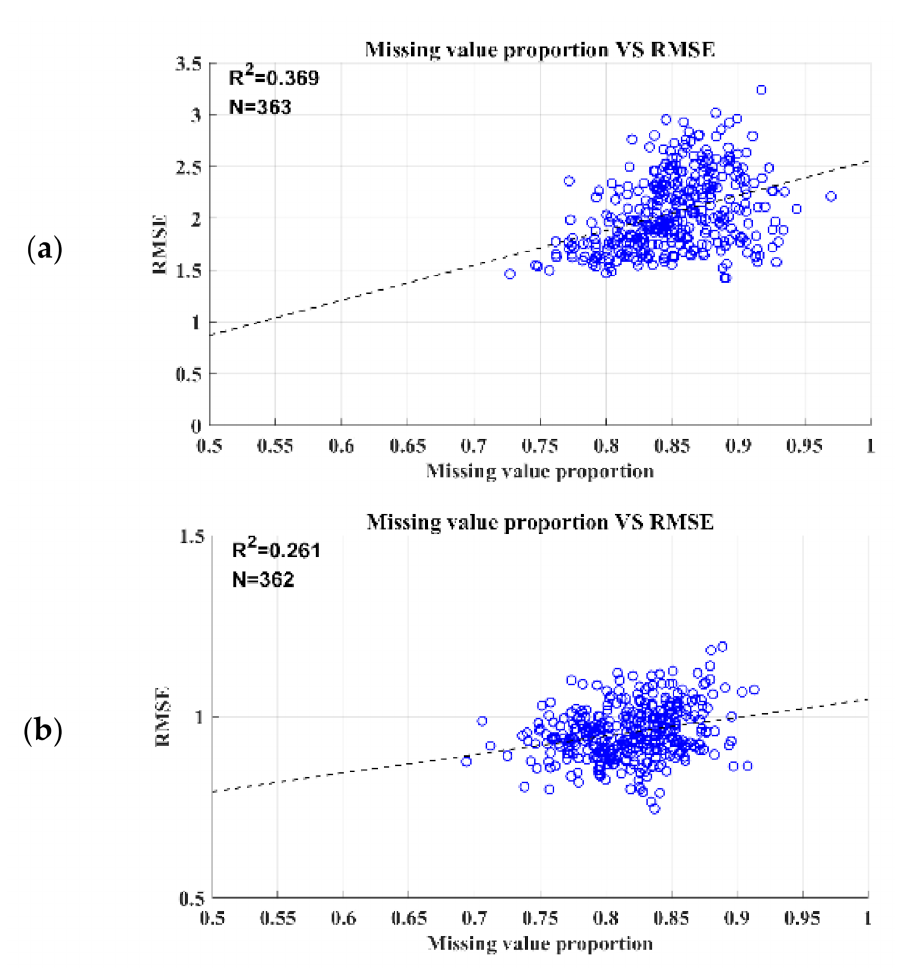
Figure 15. The scatter plot of missing value proportions and RMSE: ( a ) daytime; ( b )